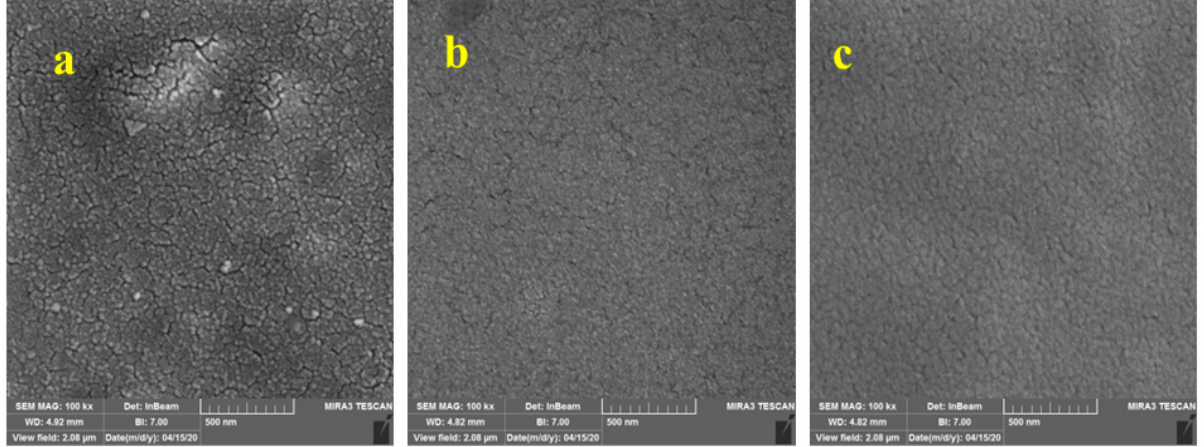
Figure 1. Surface morphologies of G/ChNF ( a ), G/ChNF/BA ( b ), and G/ChNF/SPA ( c ) smart indicators characterized by scanning electron